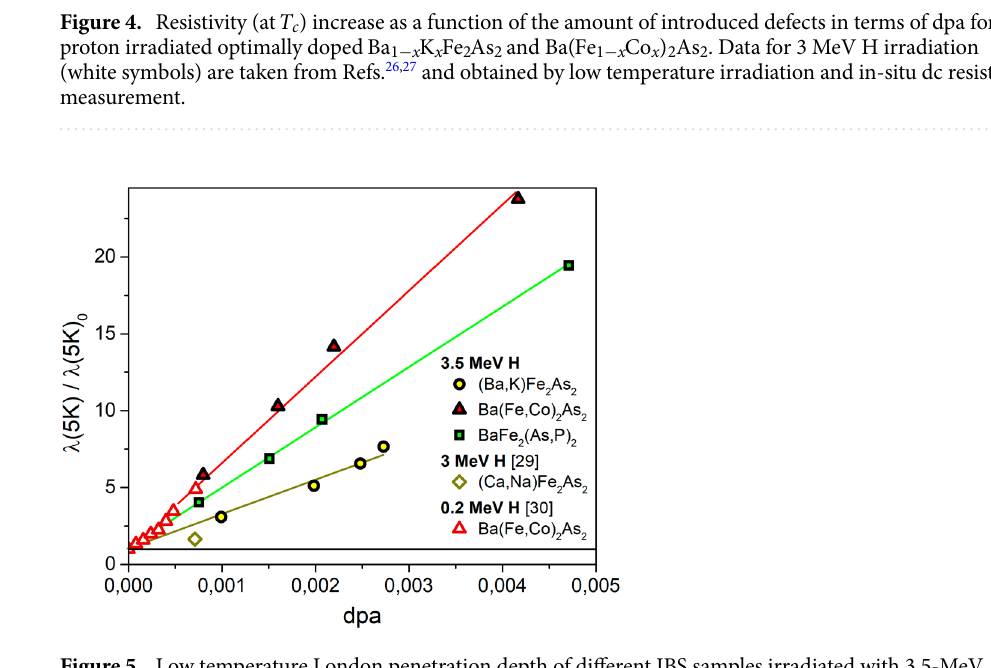
Figure 5. Low temperature London penetration depth of different IBS samples irradiated with 3.5-MeV protons, normalized to the value for the pristine one, as a function of dpa, fitted by a linear trend. Data from this work are compared to data from literature 29,30